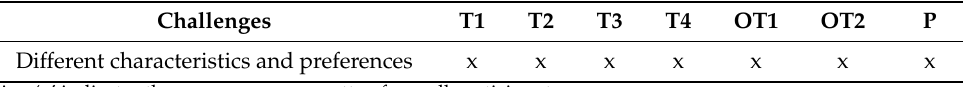
Table 4. Different characteristics and preferences of autism children. Challenges T1 T2 T3 T4 OT1 OT2 P Different characteristics and preferences x x x x x x